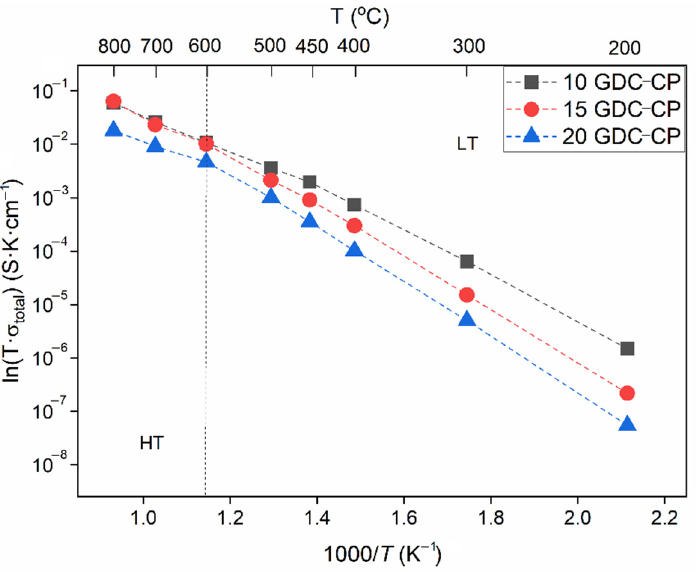
Figure 5. Temperature dependence of total conductivity of GDC ceramic pellets. The dashed line shows the separation of high- (HT) and low-temperature (LT) ranges.